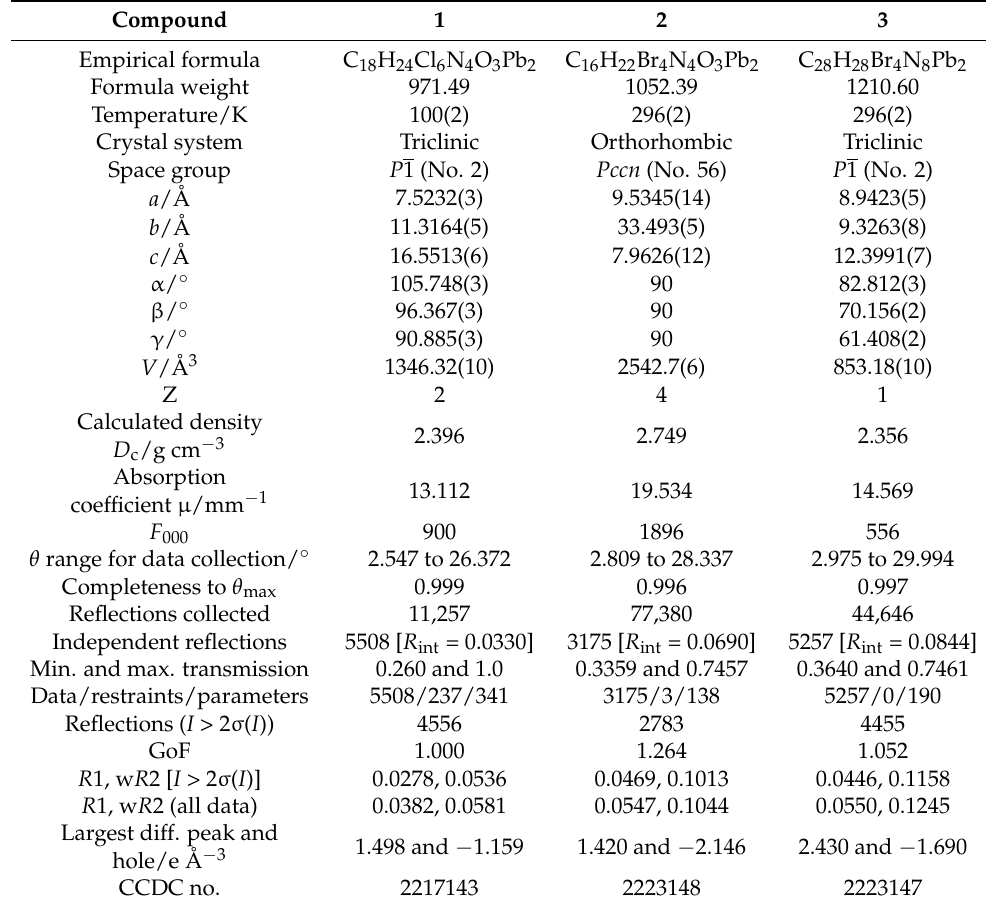
Table 1. Crystallographic parameters and refinement data for 1 − 3